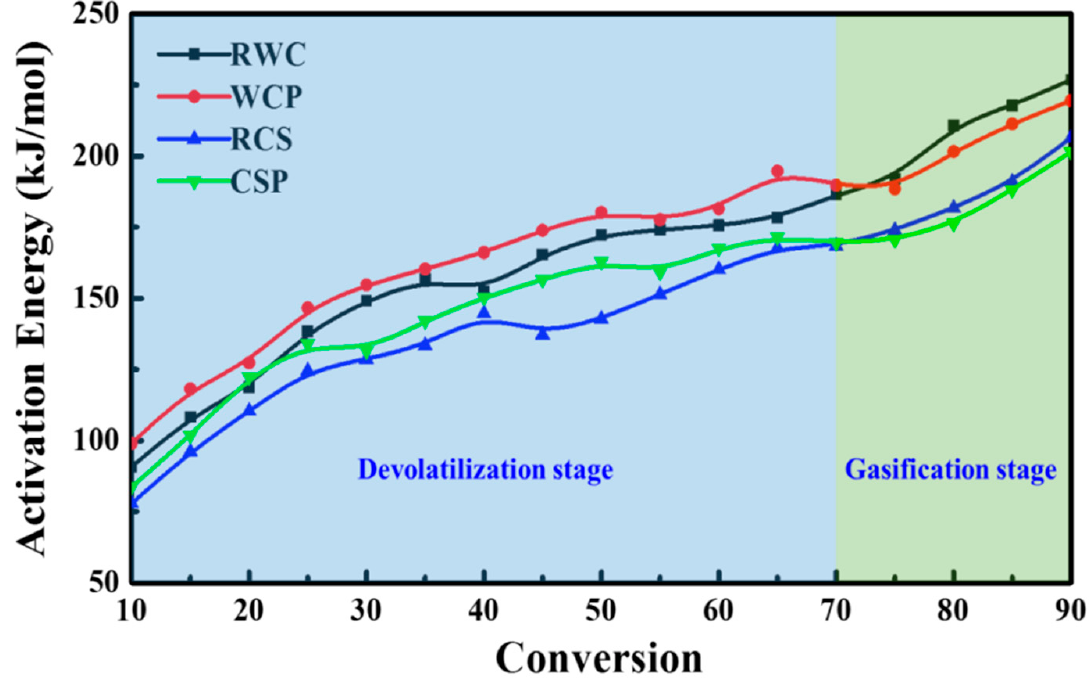
Figure 5. Activation energy distribution versus conversion rate obtained by the DAEM method.